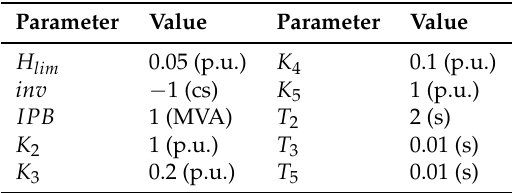
Table A3. Parameters of the PSS model used in